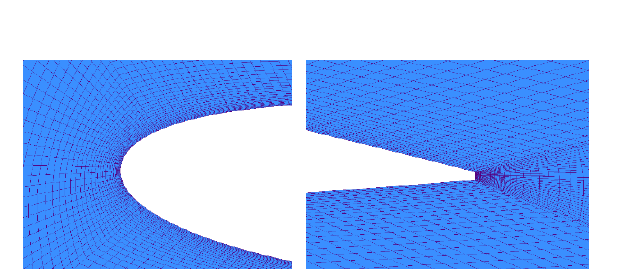
Figure 5. Mesh of NACA0015 hydrofoil.